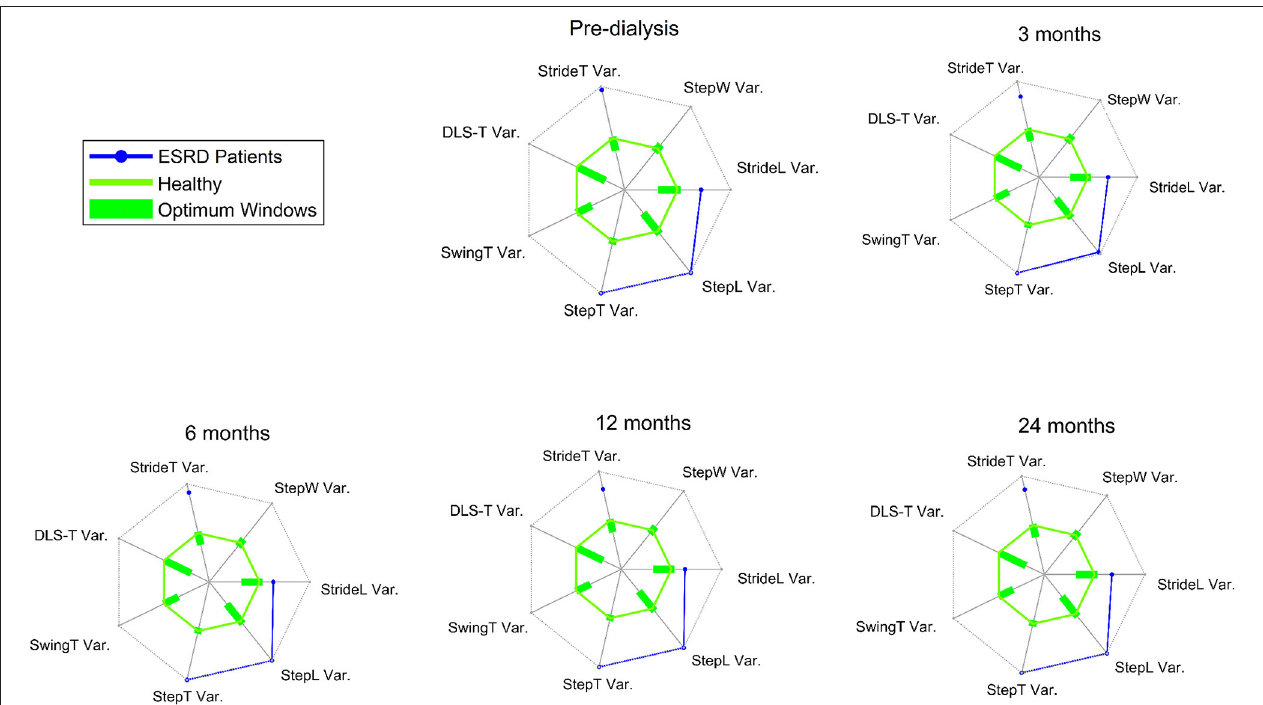
FIGURE 2 | The green solid line represents the overall mean of the commonly reported gait variability parameters for healthy asymptomatic controls, obtained from studies included within the systematic review of Ravi et al. ( 26). The optimum windows for the gait characteristics are depicted as green bars on the different axes on the radial plot. All values are presented in standardized or z-scores. The solid axes on each of the radial plots, in gray and radiating from the center of the plot, range from − 5.5 to 5.5 z-scores. In blue the measures for CKD patients. ESRD = End Stage Renal Disease; StrideT Var. = CV of stride time; StepW Var. = CV of stride width; StrideL Var. = CV of stride length; StepL Var. = CV of step length; StepT Var. = CV of step time; SwingT Var. = CV of swing time; DLS-T Var. = CV of double limb